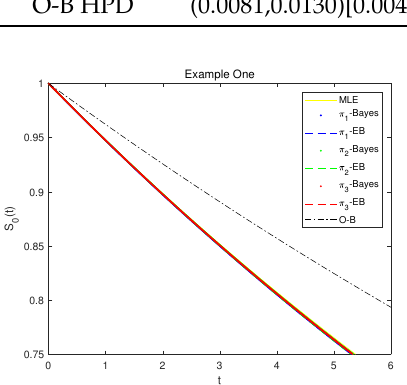
Figure 3. Plots of SF with different estimates under transformer